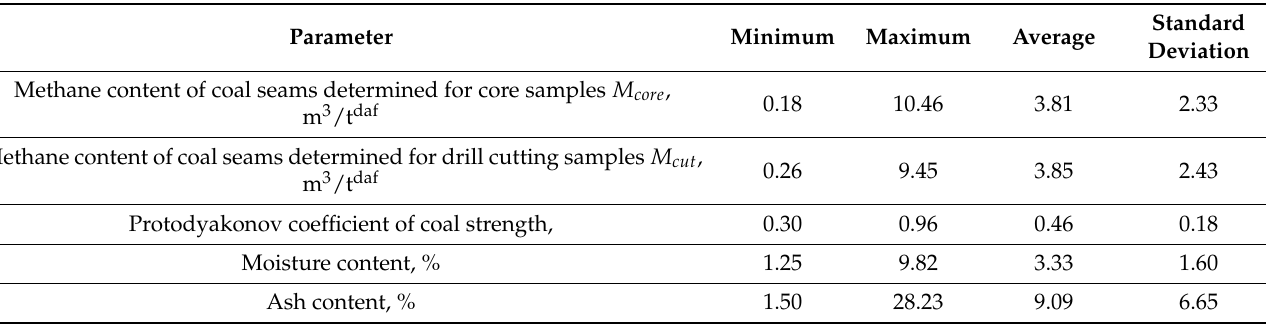
Table 2. Variation of selected physical parameters for coal